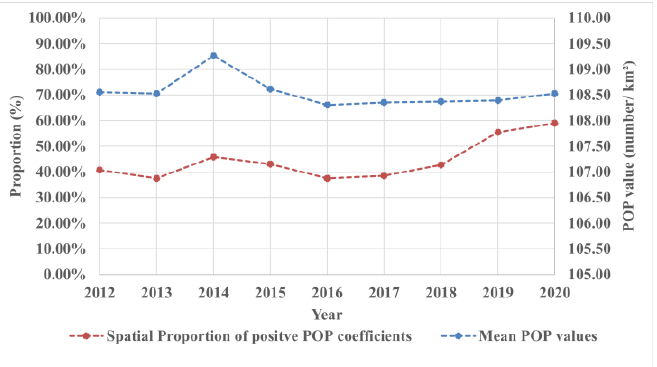
Figure 9. Temporal trends of mean POP values and spatial proportion of positive POP coefficients.